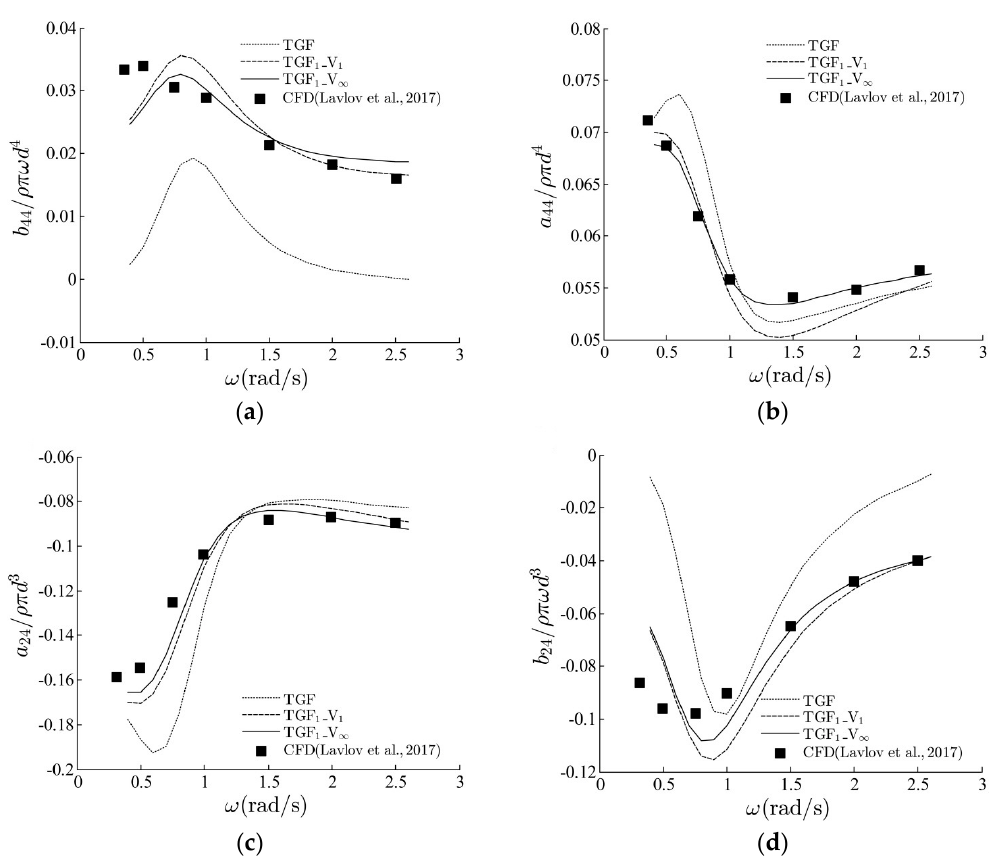
Figure 5. Hydrodynamic coefficients of section S22 using TGF, TGF 1 _V 1 and TGF 1 _V ∞ are compared with CFD results [17]. The non-dimensional viscosity coefficient in TGF 1 _V 1 and TGF 1 _V ∞ is set as (cid:101) = 0.15 on all segments and the roll of frequency ω is set as the reference frequency in viscosity coefficient: ( a ) roll-into-roll added mass coefficients; ( b ) roll-into-roll damping coefficients; ( c ) roll-into-sway added mass coefficients; and ( d ) roll-into-sway damping